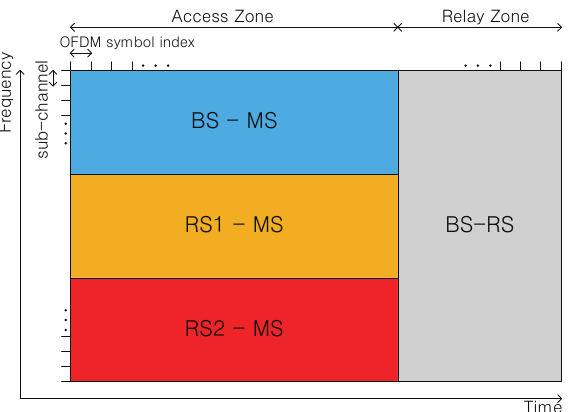
Figure 3. Downlink frame structure in a dual-hop relay